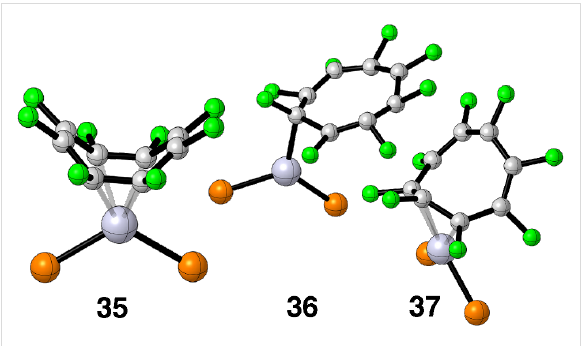
Figure 11: Three other coordination geometries that did not lead to new stationary points are shown in 35 – 37